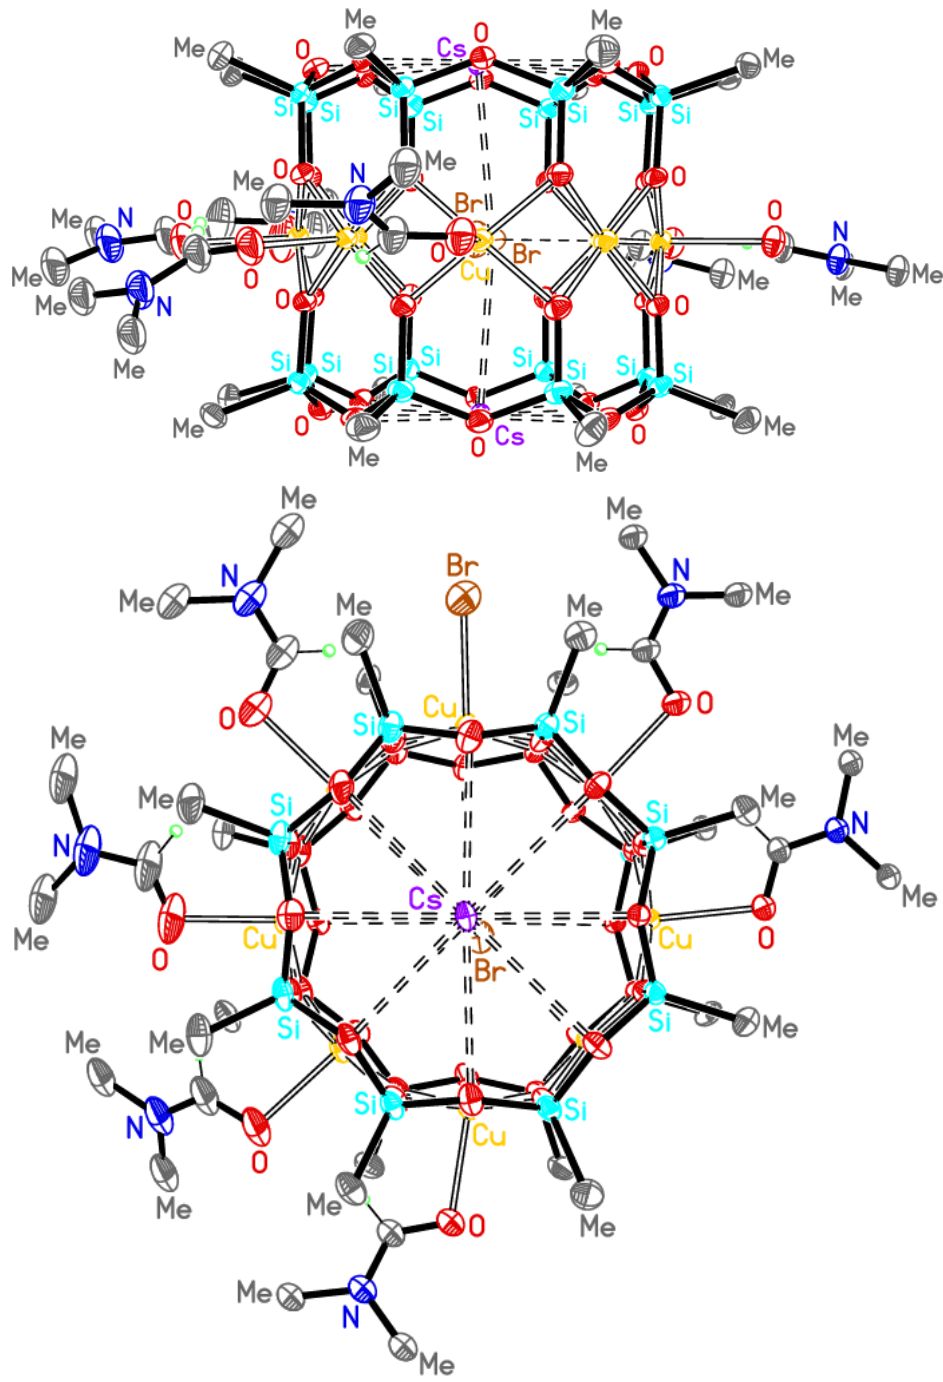
Figure 6. Two projections of molecular structure of complex [(MeSiO 2 ) 8 ] 2 Cu 8 Br 2 (DMF) 6 Cs 2 ] • 2 (DMF) sq 4 .; the solvate DMF molecules are not shown.